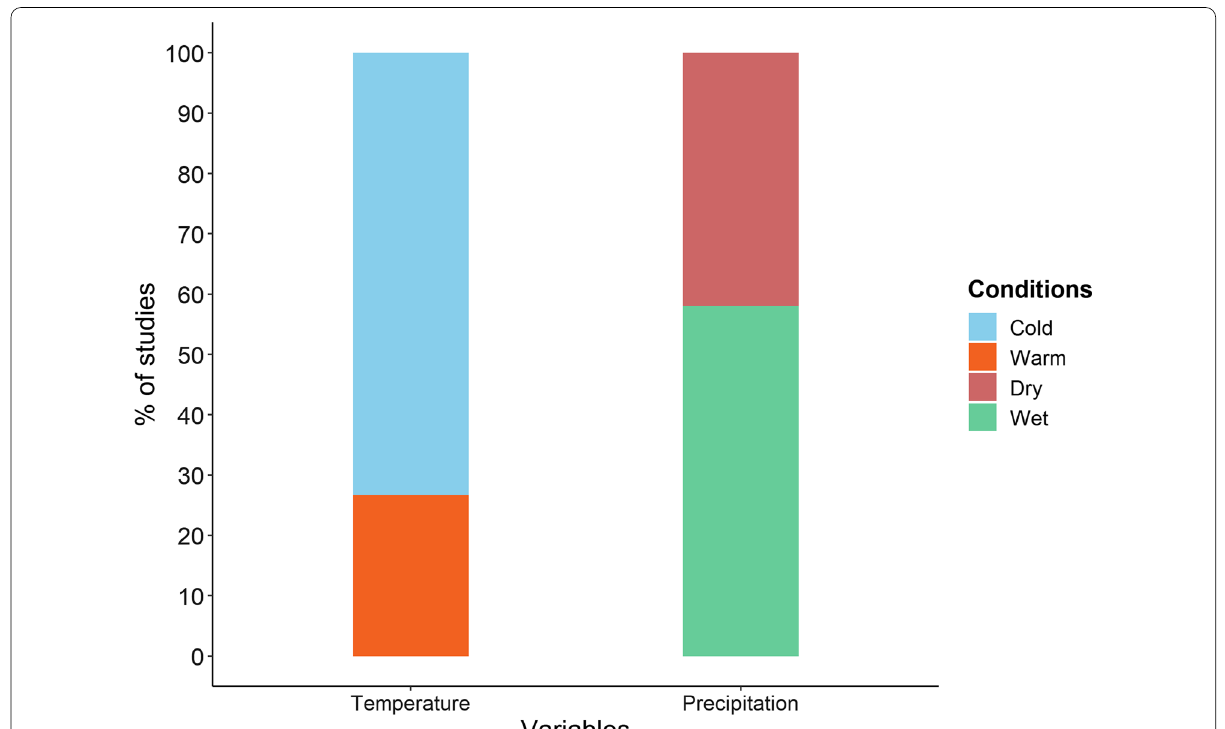
Fig. 9 Relationship of temperature and precipitation during the LIA. The number of studies used for the warm/cold or wet/dry conditions can be found in Table